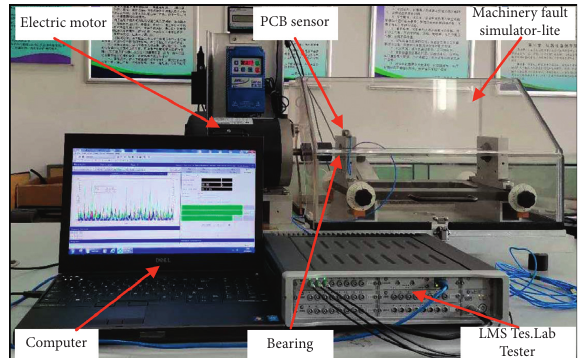
Figure 9: Flow diagram of the proposed fault diagnosis methodology.